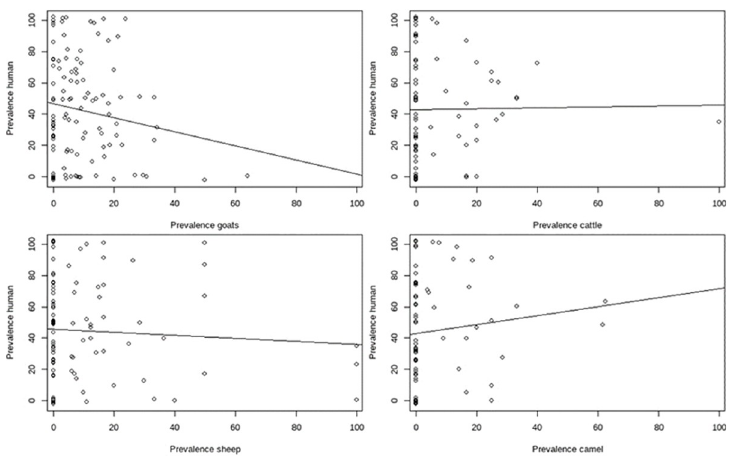
Fig 2. Correlation between animal and human sero-prevalence of Brucellosis at village